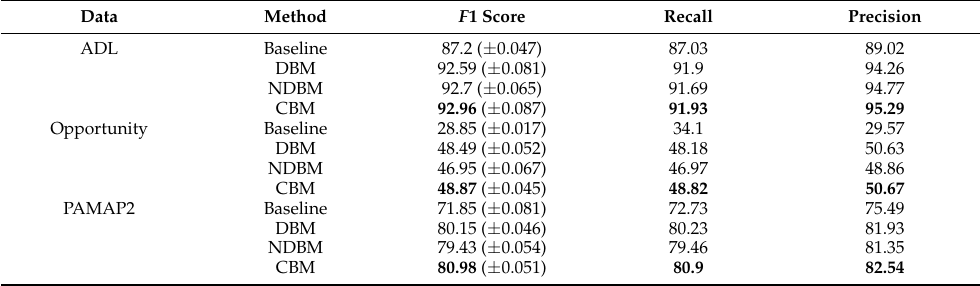
Table 7. Comparing performance of DBM, NDBM, and CBM on multiple datasets. The reported mean of F 1 scores and ( ± standard deviation), recall, and precision were obtained from 30 repetitions. The F 1 score, recall, and precision are in %. Highest scores are shown in